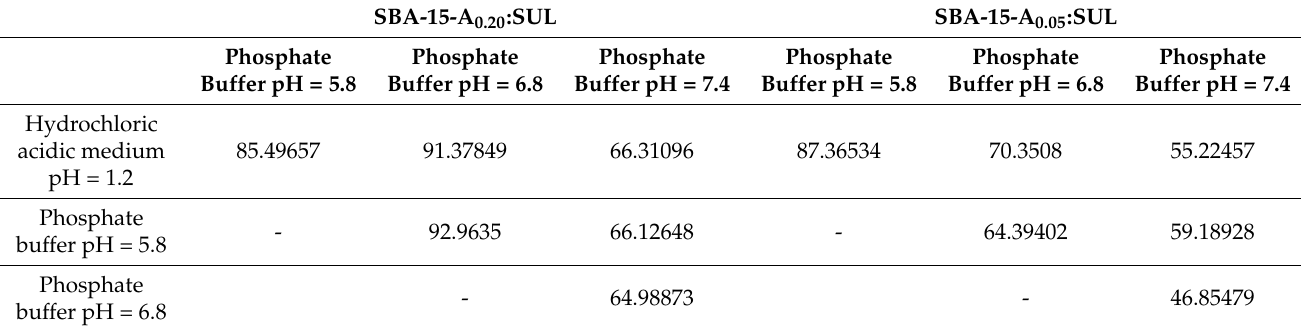
Table 3. Comparison of the similarity coefficient f 2 between mesoporous